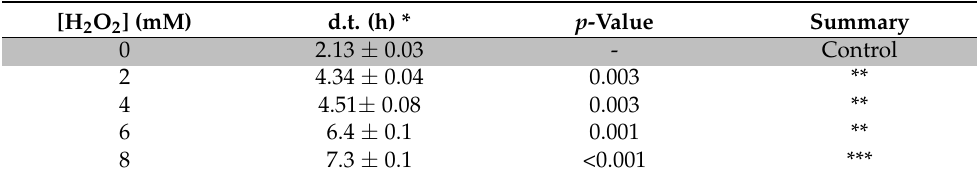
Table 4. Doubling time of Hfx. mediterranei growth in the presence of different H 2 O 2 concentrations to induce oxidative stress.